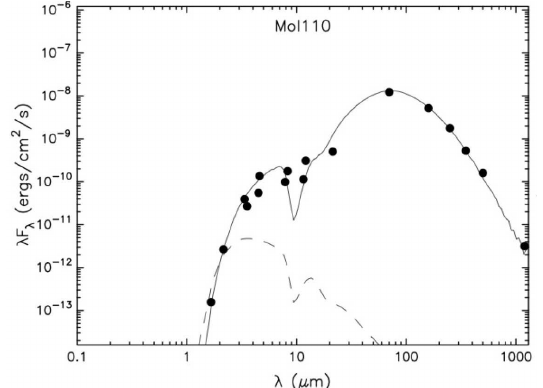
Figure 4: Spectral energy distribution (SED) of Mol 110 The observed luminosity of 1.13 10 4 L (cid:12) correspond to that of a B1-2 ZAMS star reddened by 50.2 magni- tudes of extinction in V.